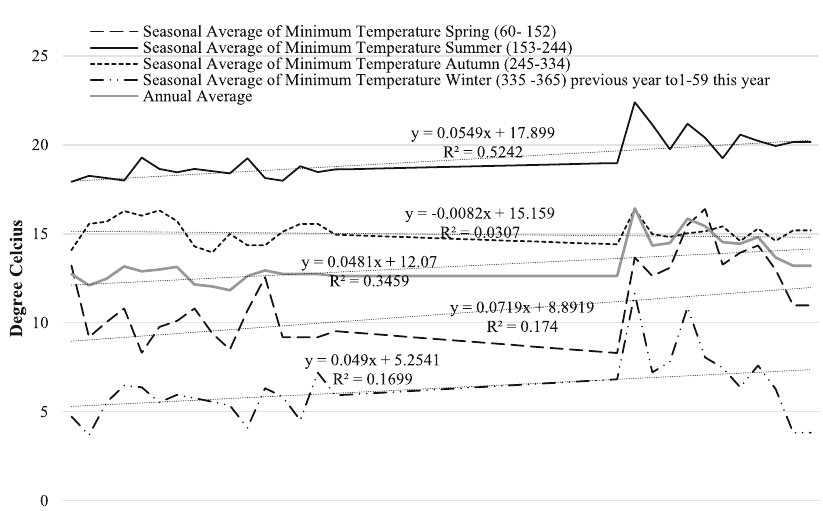
Fig. 5 Changes in Average Minimum Temperature in Upper-Mustang (Chhoser Meteorological Station), Nepal by Seasons (1974 – 2015), (Source: DHM/Govt of